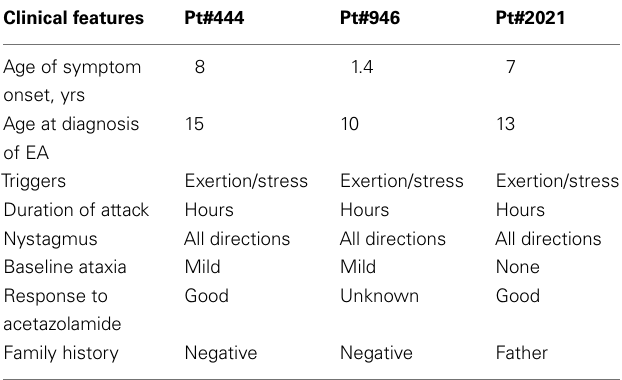
We confirmed the 200 kb deletion, for which the 5 (cid:2)